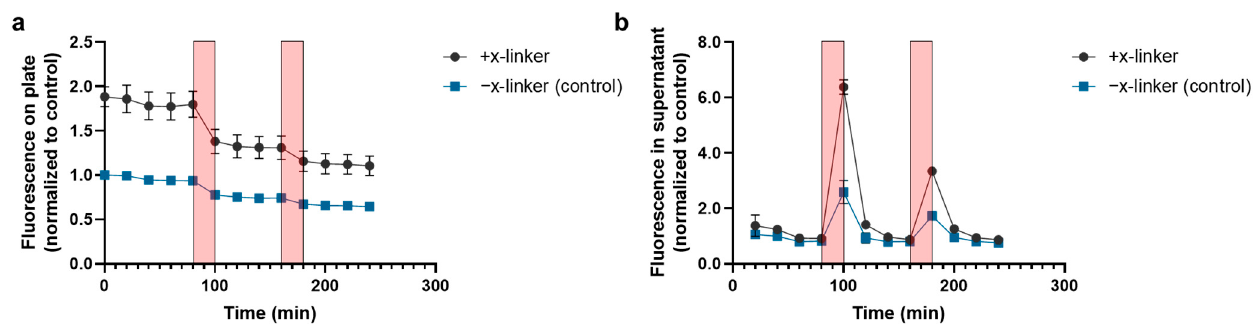
Figure 4. Time-dependent fluorescent intensity of ( a ) the chitosan-coated substrate and ( b ) the supernatant, which were exposed to two heating cycles (red boxes). The fluorescent intensity was normalized to the control group ( − x-linker; non-specifically adsorbed oligonucleotide) (n = 3).